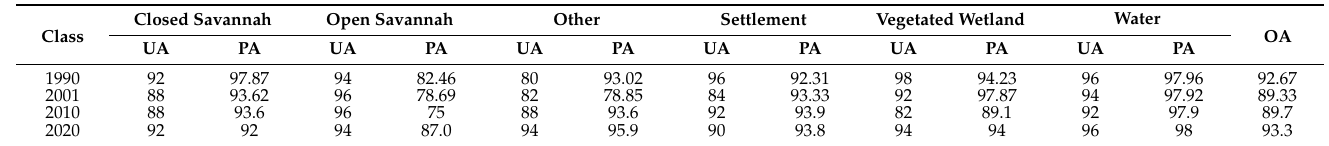
Table 5. User’s accuracy (UA), producer’s accuracy (PA) and overall accuracy (OA) for land use land cover classification accuracy assessment for the time